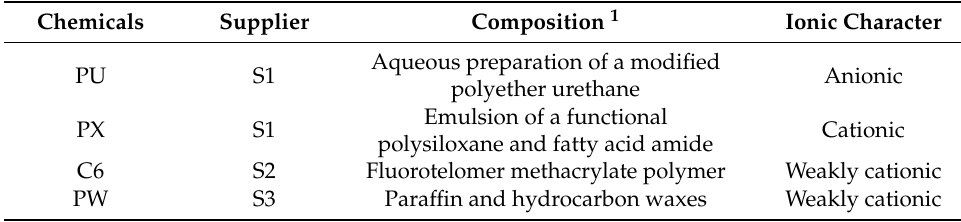
Table 1. Chemicals used for shrink-proofing and water-repellent treatments.